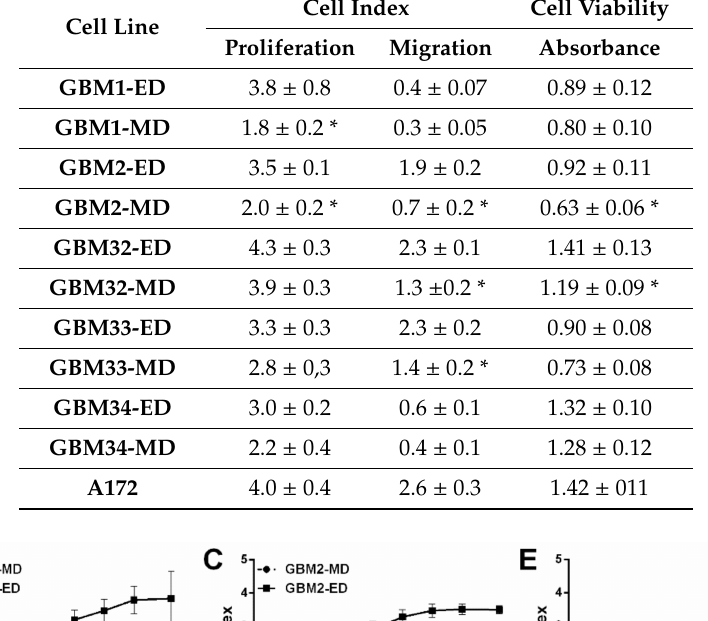
Table 1. The cell index value and the cell viability of five primary glioblastoma cells (GBM1, GBM2, GBM32, GBM33, and GBM34) isolated using enzymatic method (ED) and mechanic method (MD) from the GBM of five patients during 99 h (cell proliferation) and during 24 h (cell migration). Results were compared with stabilized cell line A172. * Absorbance (cell viability) was determined after 72 h cultivation using WST-1 analysis. p < 0.05 enzymatic vs. mechanic dissociation; data are expressed as average ± SD.